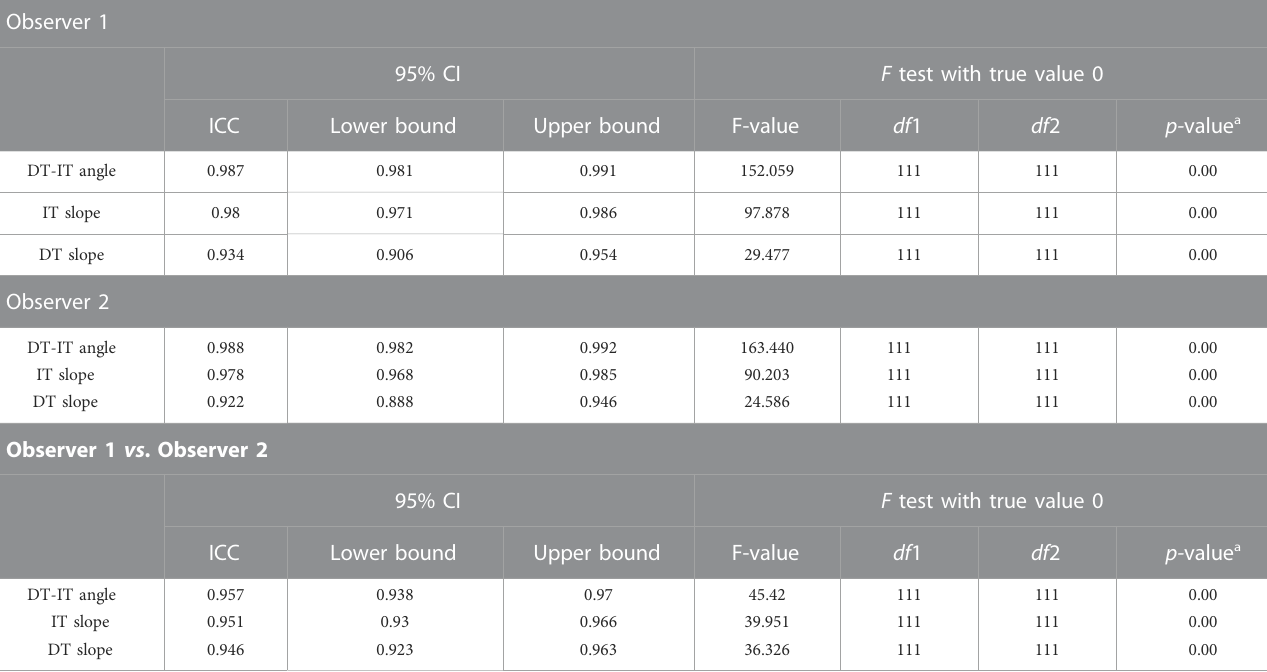
TABLE 3 ICC intra- and inter-observer analysis of the DT-IT angle, IT slope, and DT slope measurements, including intraclass correlation coef fi cient (ICC) and 95% con fi dence interval (CI). Observer 1